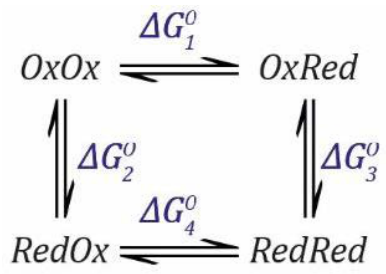
Scheme 6. Scheme showing the free energies associated with reactions in a simple two-step redox model. The doubly oxidised species OxOx can be reduced to OxRed or RedOx with free energy changes ∆ G 1 and ∆ G 2 , respectively. OxRed and RedOx can then be further reduced to RedRed with free energy changes ∆ G 3 and ∆ G 4 ,